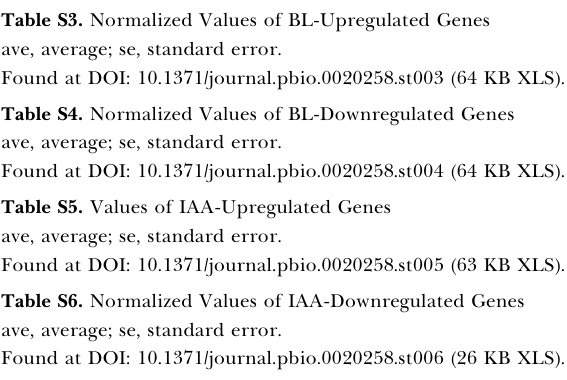
Table S1. Fold Change of BL-Upregulated Genes following Exposure to BL or IAA (Auxin) Treatment Effects of increased auxin levels in the yucca mutant are shown as compared to WT and following BL treatments. The comparisons from left to right are WT BL- versus mock-treated, WT IAA- versus mock-treated, yucca mock-treated versus WT mock-treated, and yucca BL- versus mock-treated. nc, no change. Table S2. Fold Change of BL-Downregulated Genes following Exposure to BL or IAA (Auxin) Treatment Effects of increased auxin levels in the yucca mutant are shown as compared to WT and following BL treatments. The comparisons from left to right are WT BL- versus mock-treated, WT IAA- versus mock-treated, yucca mock-treated versus WT mock-treated, and yucca BL- versus mock-treated. nc, no change. Table S3. Normalized Values of BL-Upregulated Genes ave, average; se, standard error. Found at DOI: 10.1371/journal.pbio.0020258.st003 (64 KB XLS). Table S4. Normalized Values of BL-Downregulated Genes ave, average; se, standard error. Found at DOI: 10.1371/journal.pbio.0020258.st004 (64 KB XLS). Table S5. Values of IAA-Upregulated Genes ave, average; se, standard error. Table S6. Normalized Values of IAA-Downregulated Genes ave, average; se, standard